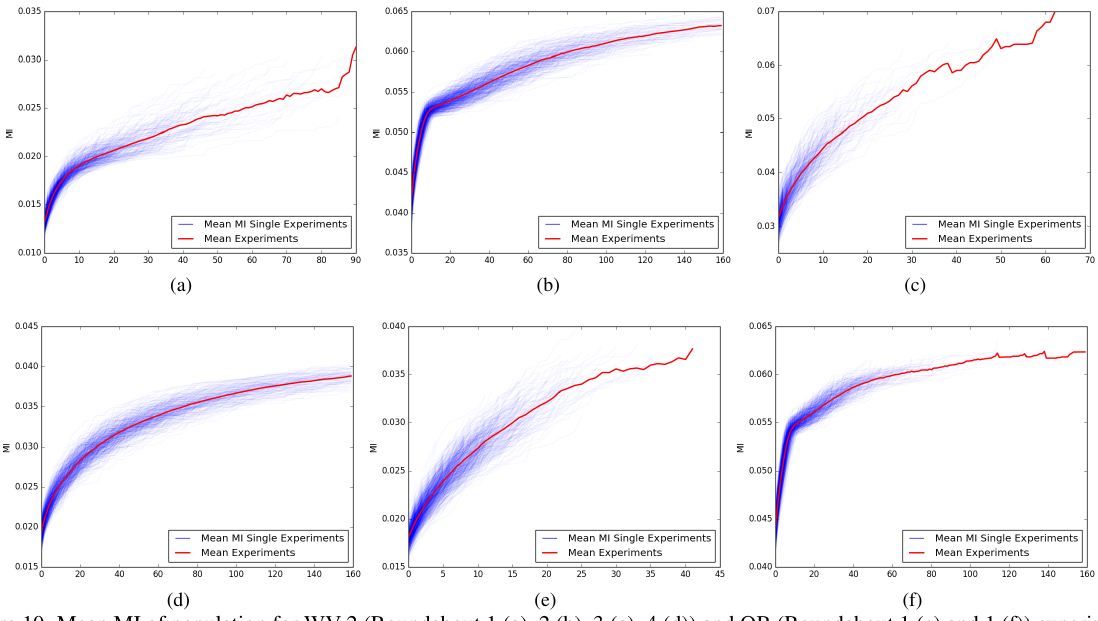
Figure 10. Mean MI of population for WV-2 (Roundabout 1 (a), 2 (b), 3 (c), 4 (d)) and QB (Roundabout 1 (e) and 1 (f))